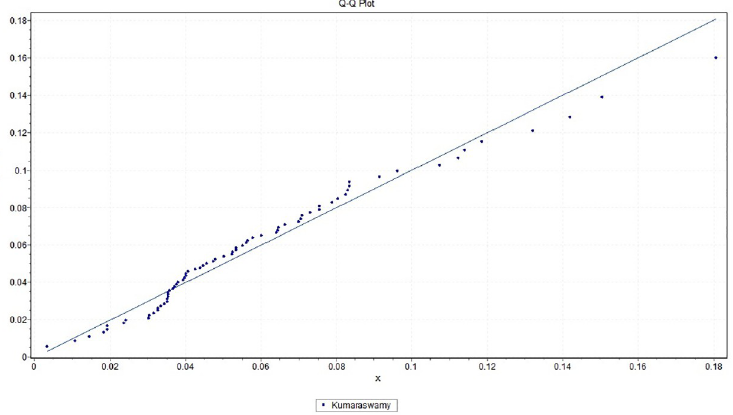
years, the first number being 0.654 for the period 1890–1893, and the last one being 0.265, which is for the time period 1966–1969. The data were utilized by [28] and it is given in Table (1). It is observed that K - S = 0.21091 with p = 0.29281, A - D = 0.93218 and chi-square dis- value tance = 2.4424 with a corresponding p = 0.29488. This indicates that the Kumaraswamy value model provides a good fit to the above data. Fig (7) gives the histogram of the data-set and the plots of the fitted density. The QQ plot in Fig (8) suggests that Kumaraswamy is very suitable